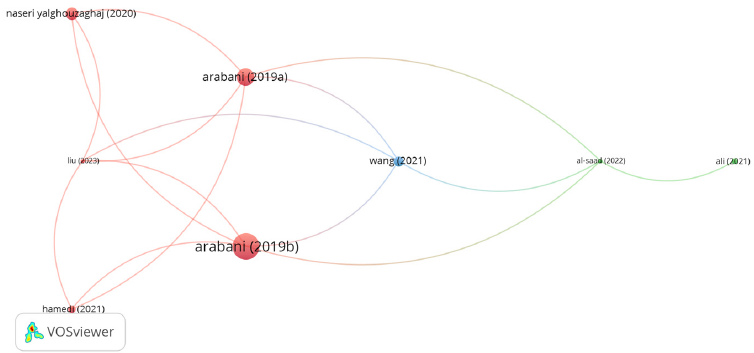
Figure 10. Network visualization of ceramic fibers.